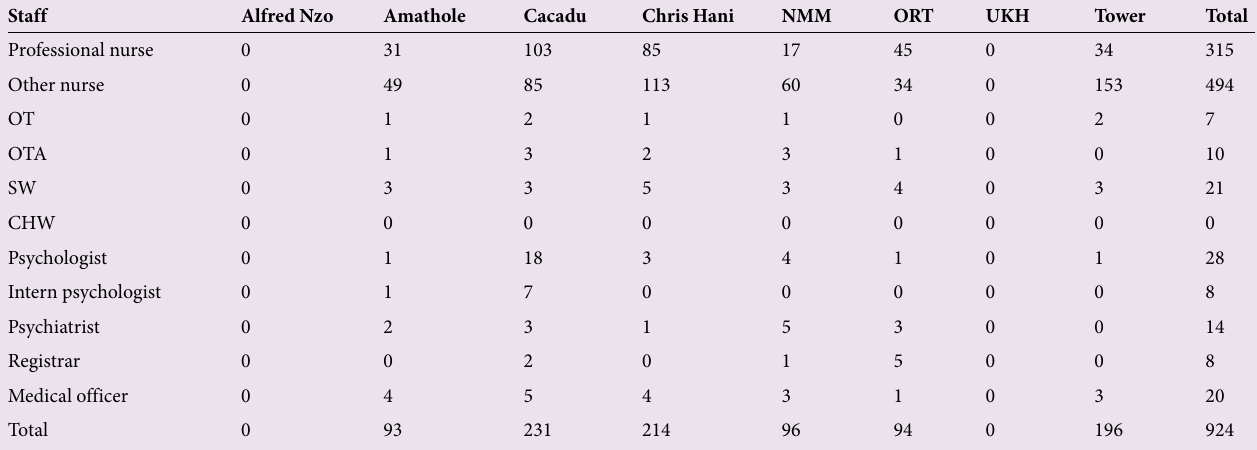
Table 3. Staff distribution per district